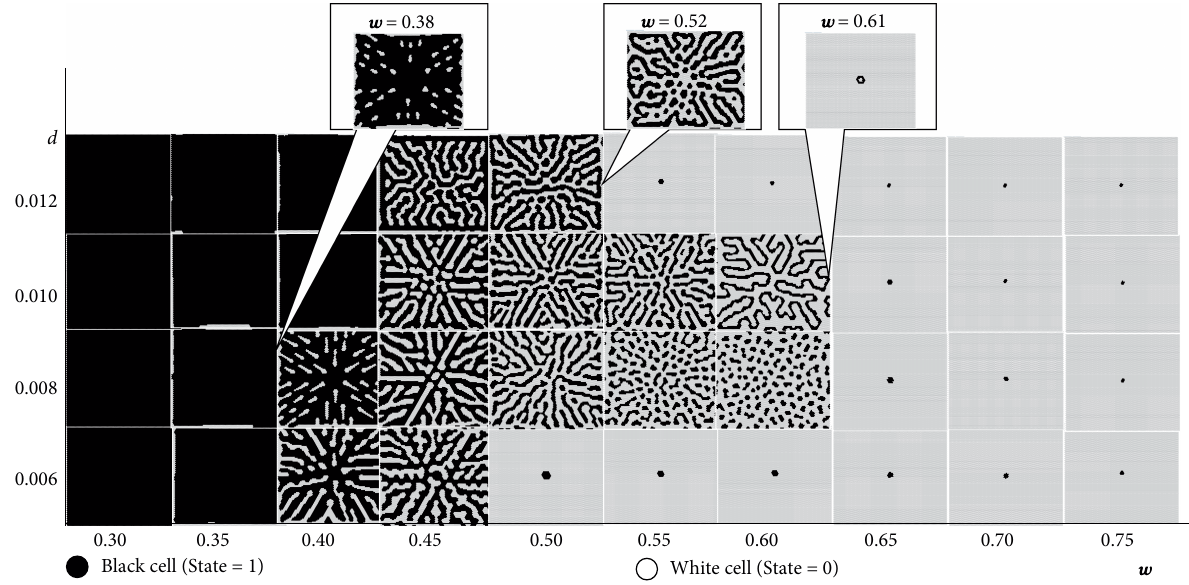
Figure 8: Simulation results for w and 𝑑 ( 푏 = 10,000 , 푟 = 0.05 ). Four black cells were placed in the simulation field as an initial condition. For 푑 = 0.008 , self-organized patterns emerged over a wide range of w . Spotted patterns appeared for w ∼ 0.6, and striped patterns appeared for w ∼ 0.4 − 0.5. For 0.008 < 푑 < 0.010, various spatial patterns appeared. Overall, when w was increased, a steady state appeared in the form of a single black spot. As 𝑑 was increased, labyrinthine patterns emerged (e.g., w = 0.6 , 푑 = 0.010 ). Specifically, when the value of d was increased, unique patterns emerged.